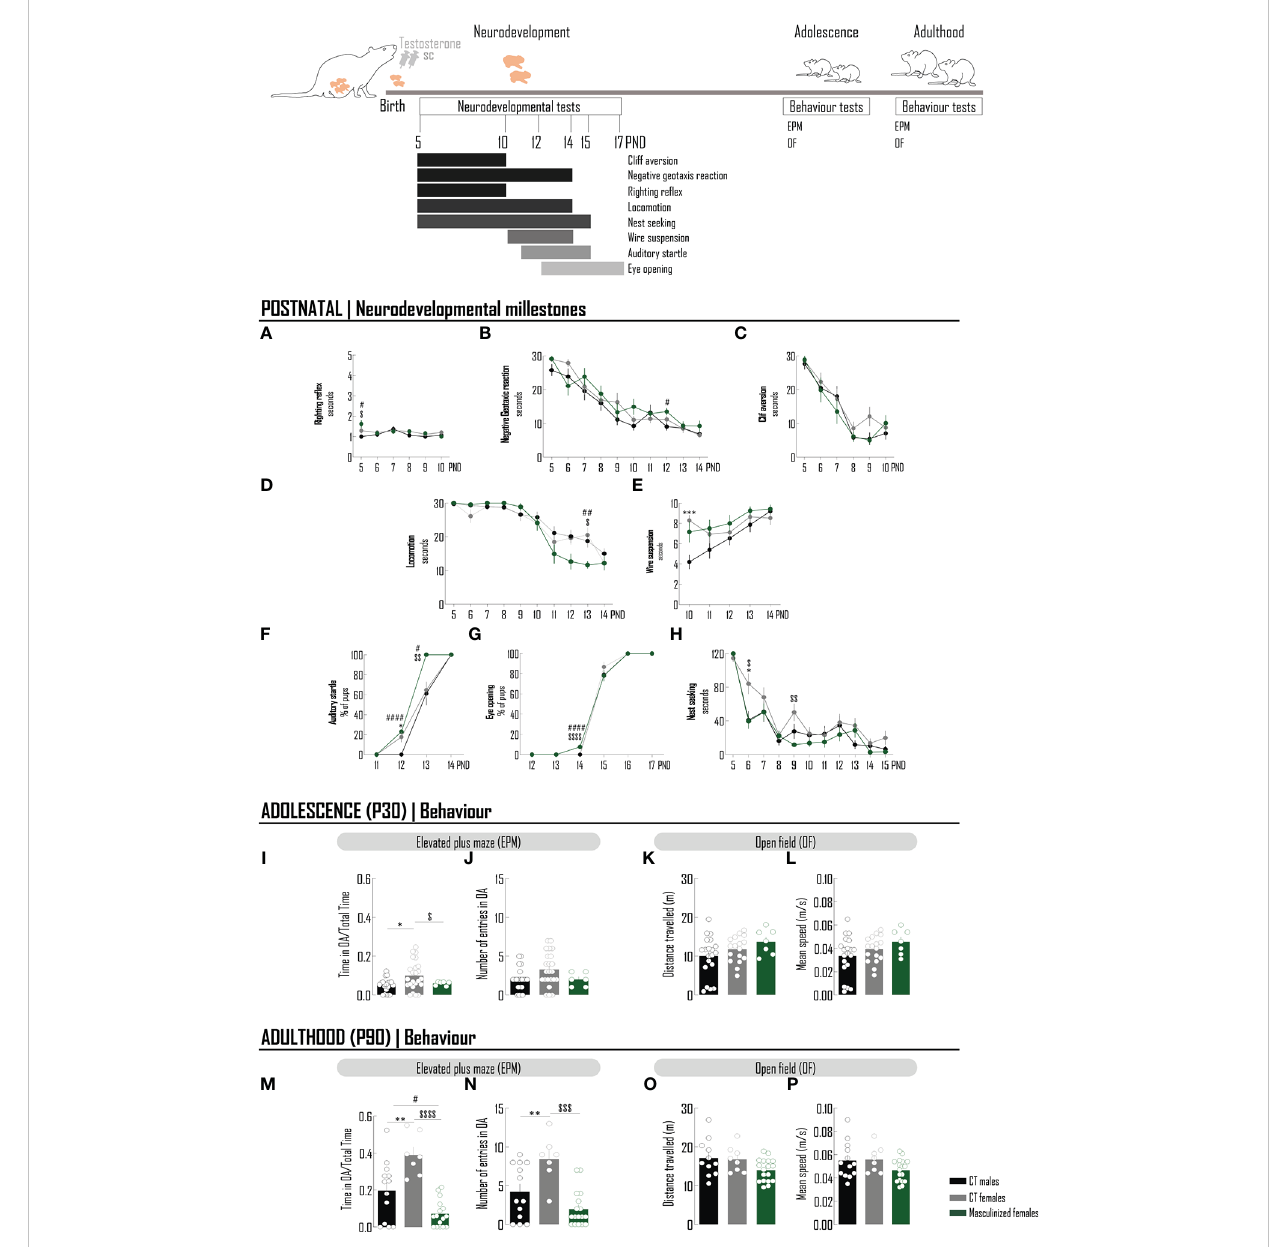
FIGURE 4 The acute administration of testosterone to newborn females masculinizes the behavior in the anxiogenic conditions of the EPM test. Schematic drawing of the pharmacological treatment: female Wistar rats were injected with testosterone (100 µg/25 µL, sc) at PND0. Chronology of the neurodevelopmental milestones and behavioral tests performed in animals at postnatal period, adolescence and adulthood. A battery of neurodevelopmental tests was conducted to evaluate re fl exes - righting re fl ex (A) , negative geotaxis reaction (B) and cliff aversion (C) , motor skills - locomotion (D) and wire suspension (E) , sensorial system - auditory startle (F) , eye opening (G) and social behavior – nest seeking (H) . To the majority of tests, latency to achieve the goal was recorded (A – E, H) . For auditory startle (F) and eye opening (G) , the percentage of pups was determined. At adolescence (I – L) and adulthood (M – P) , the elevated plus maze and open fi eld tests were performed. To evaluate the performance in an anxiogenic context, the time spent in OA per total time of the EPM test (I, M) and the number of entries in the OA (J, N) were recorded. Locomotion was assessed by measuring the distance travelled (K, O) and the mean speed (L, P) . Results are presented as mean ± SEM. * p <0.05 comparing CT males (black circles) and females (gray circles). # p <0.05 comparing CT males and females masculinized (green circles); $ p <0.05, comparing CT females and females masculinized. SC, subcutaneously; PND, postnatal day; EPM, elevated plus maze; OA, open arms; OF, open fi